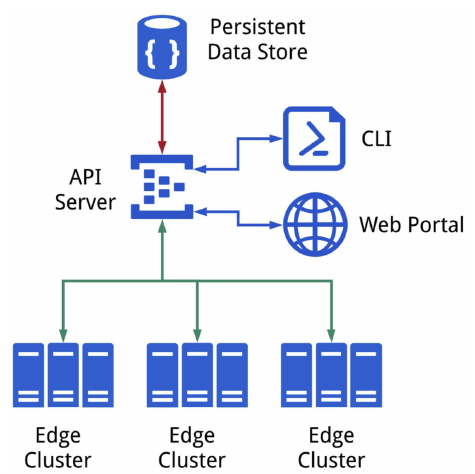
Figure 4: The central API server accepts